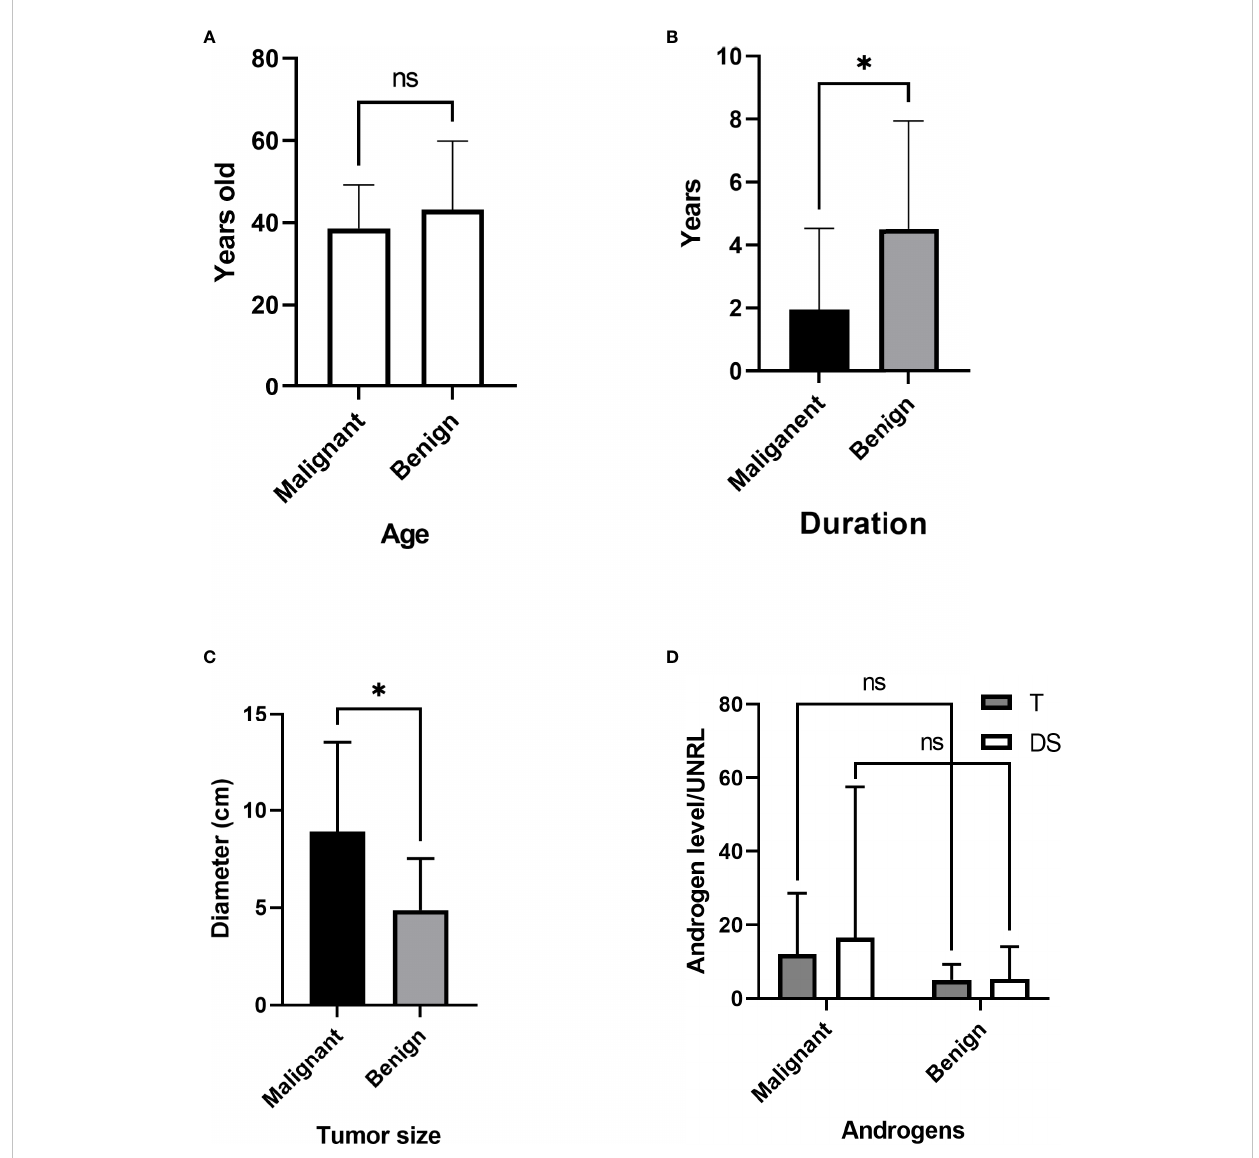
FIGURE 6 Comparison of malignant and benign tumors. (A) Age differences. (B) Duration before diagnosis. (C) Tumor size. (D) Androgen level. T, testosterone; DS, dehydroepiandrosterone sulfate; UNRL, upper normal range limit. ns, not signi fi cant; *